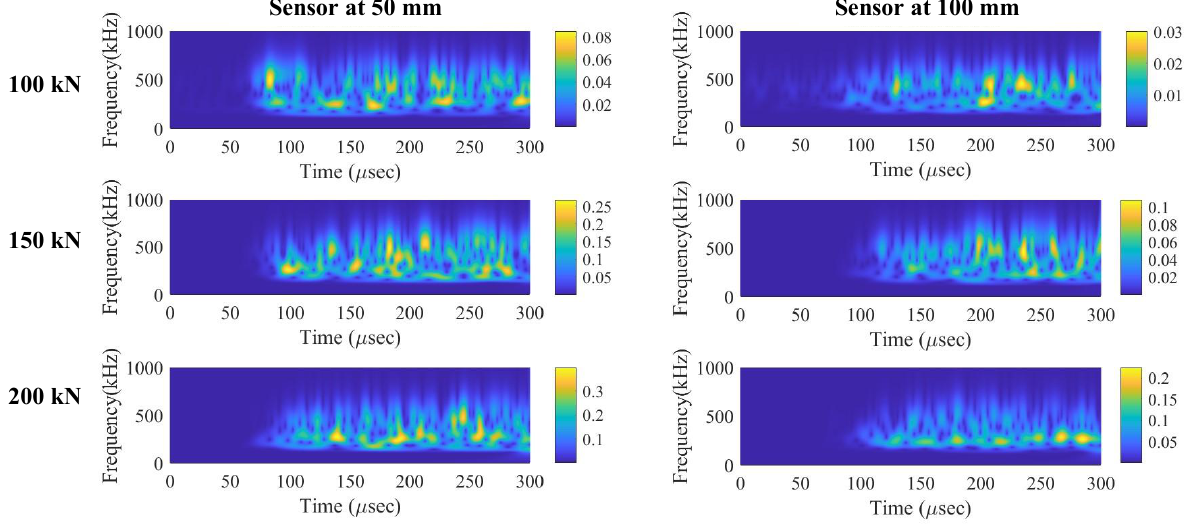
Figure 17. Comparison of relative energy generated through MODWT of signals for various loads. [Colour gradient: red to green corresponds to high to low relative energy]. It is evident that the frequency levels 4 and 5 is predominantly present in all the signals. The sensor closer to the crack has concentrated energies in these two levels, while the sensor far away from the crack has more distribution of energy. Figure 18 shows the